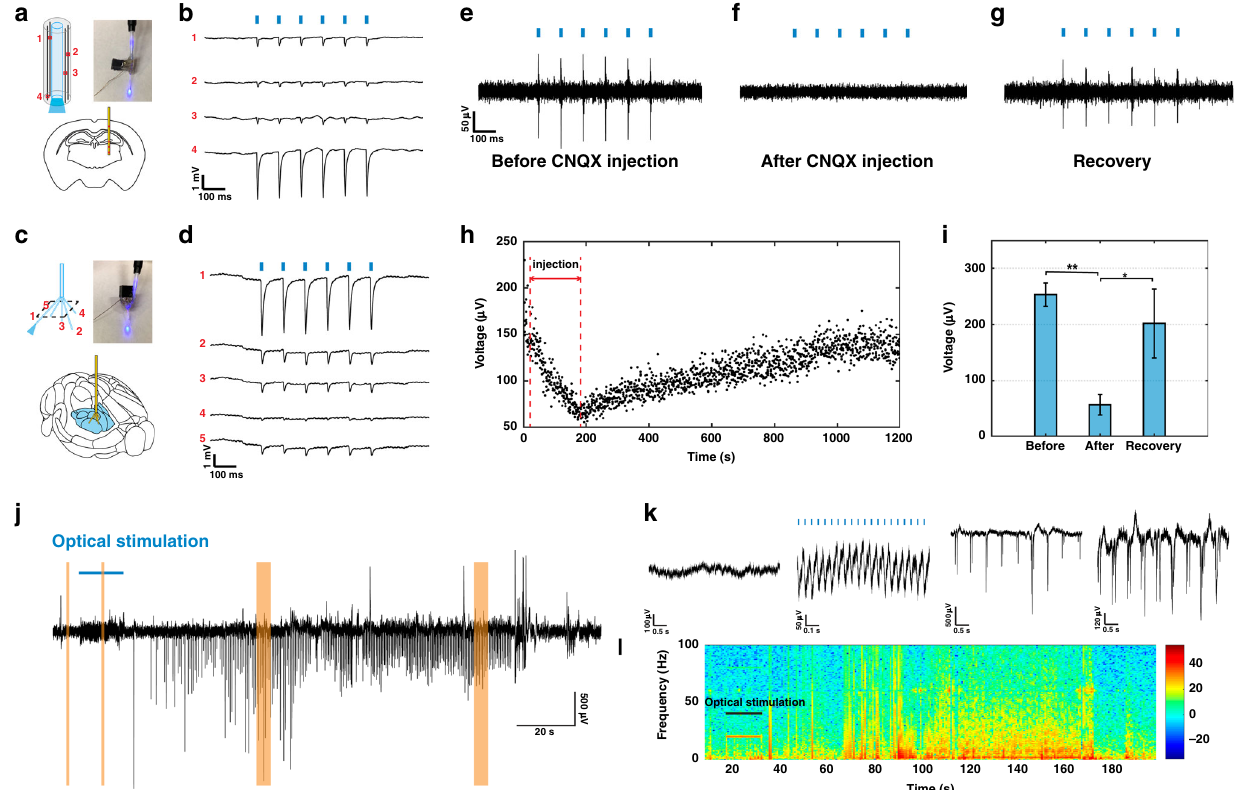
Fig. 4 Simultaneous multisite optogenetic stimulation, electrical recording, and drug delivery. a An illustration of the depth-dependent multimodal fi ber probe targeting cortex, hippocampus and thalamus regions in a transgenic Thy1-ChR2-YFP mouse brain and a photograph of the assembled device coupled to the 473 nm laser. b Un fi ltered electrophysiological recording from depth-electrodes 1 – 4 during optogenetic stimulation (10 Hz, 5 ms pulse width, 7.3 mW/mm 2 ) 5 months after implantation ( n = 5). c An illustration of the spatially expanded multimodal fi ber probe targeting the thalamus region in